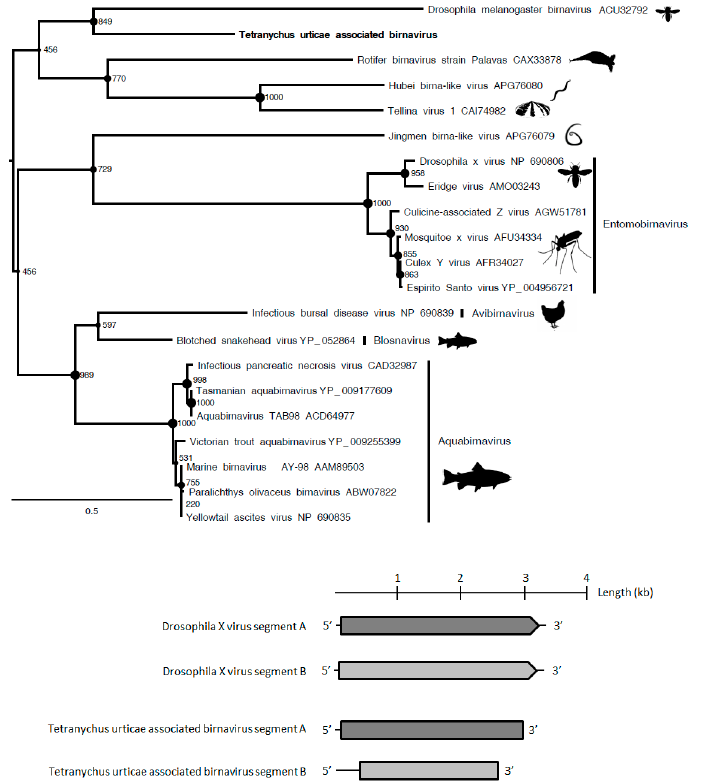
Figure 3. Maximum Birnaviridae likelihood phylogenetic tree based on part of the polyprotein, including 20 birnavirus species and Tetranychus urticae-associated birnavirus (in bold). The alignment of 602 amino acids in length was produced using MUSCLE 3.7 (16 iterations) and was ungapped by hand. The tree was mid-point rooted. Bootstrap values are indicated at each node. Scale bar corresponds to amino acid substitutions per site. Genera of the Birnaviridae family are indicated in brackets. Genomic organization of Tetranychus urticae-associated birnavirus is also indicated. Grey arrows and rectangles: predicted open reading frames (ORF), Light grey: putative NS; dark grey: putative capsid protein (CP). Arrow: complete ORF; Rectangle: truncated ORF.